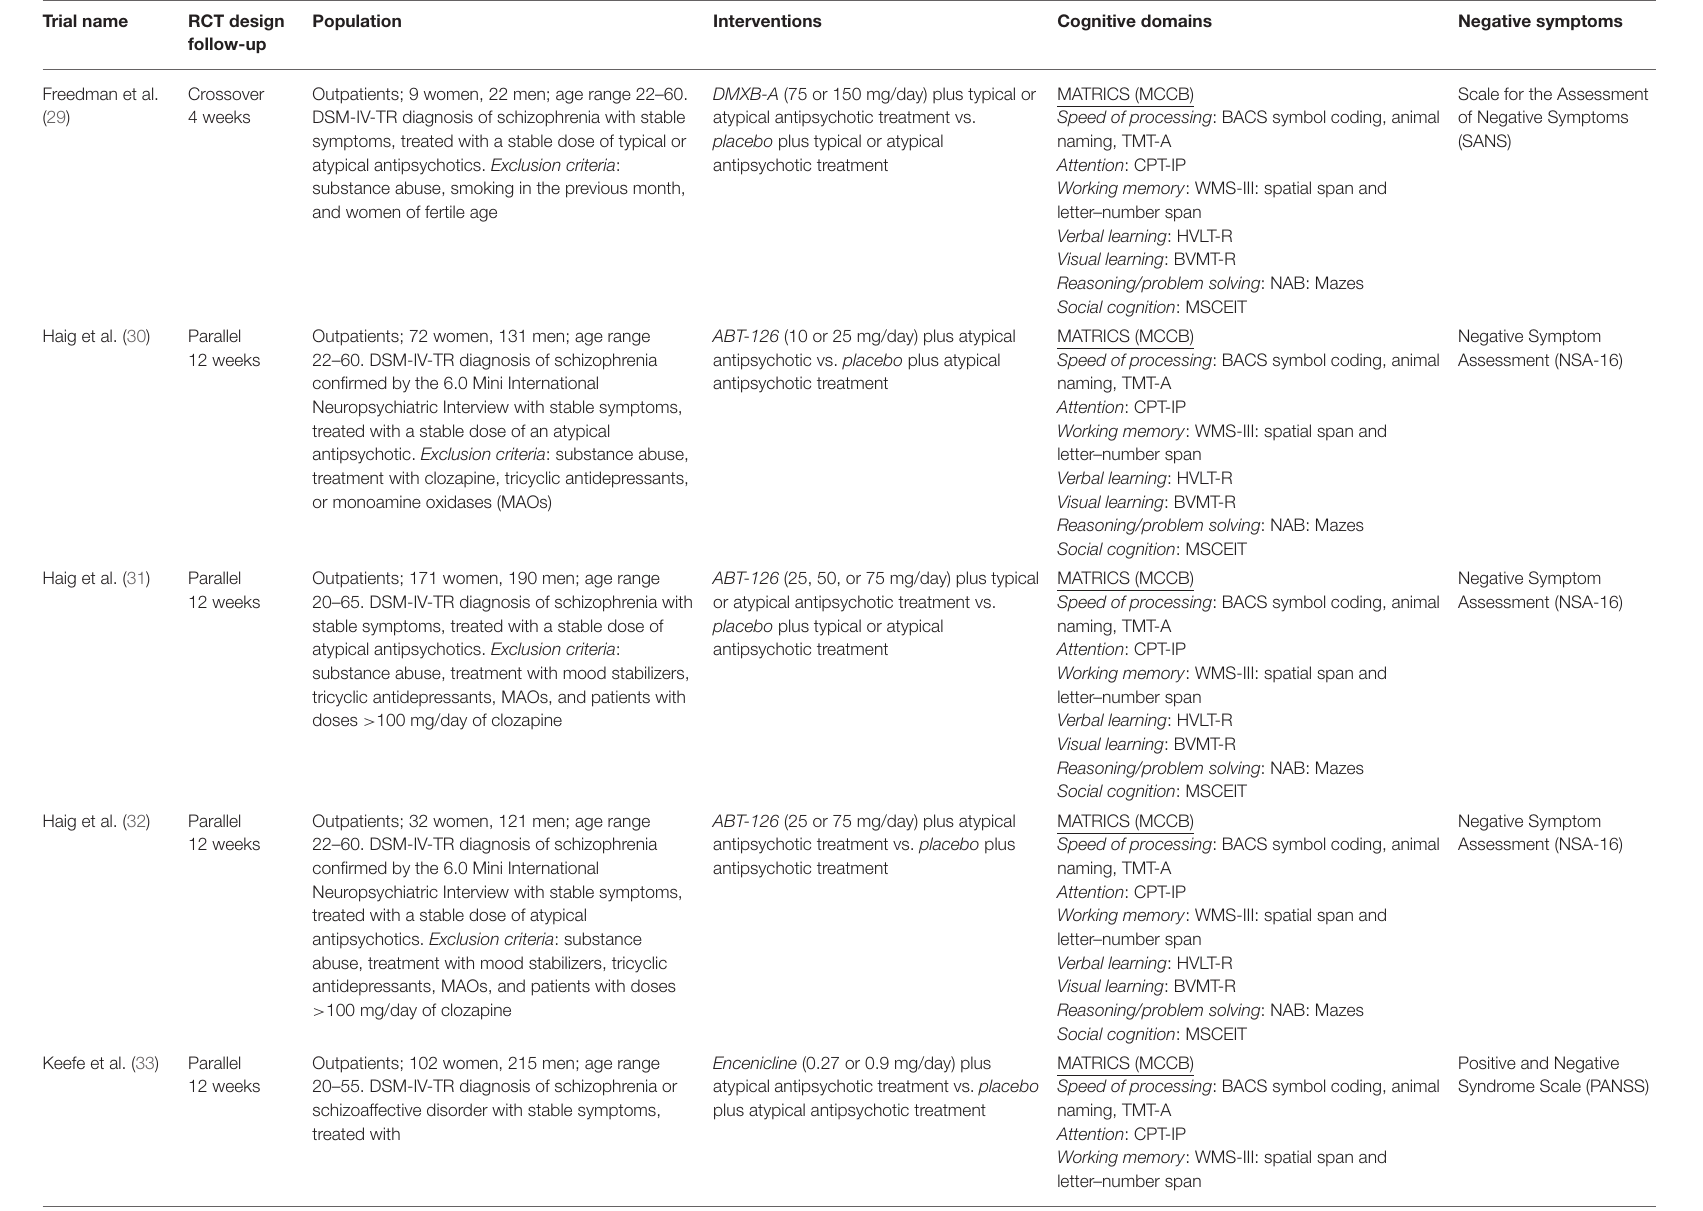
TABLE 1 | Characteristics of the studies included in the systematic review and meta-analysis of cognitive deficits and negative symptoms in